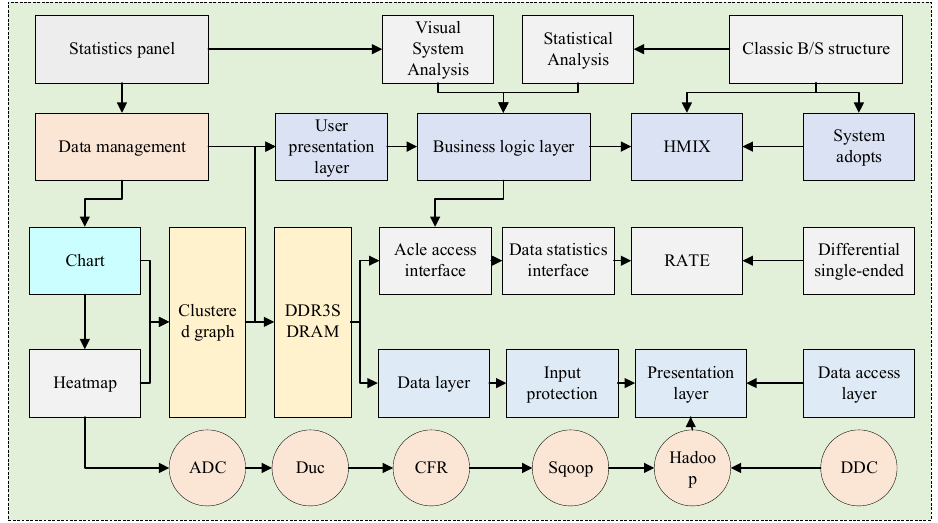
Figure 3. Overall design of the system.